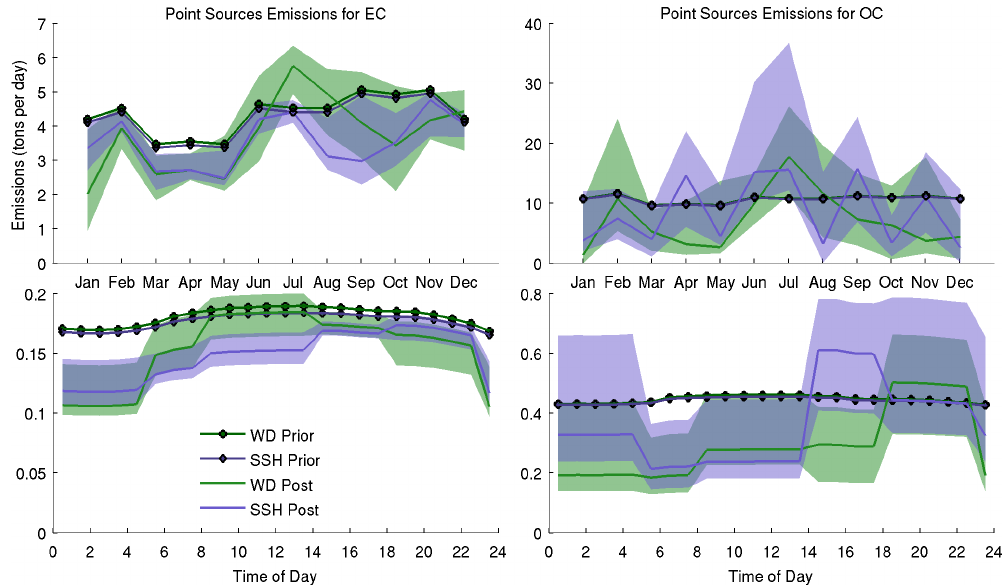
Figure 14. Monthly and diurnal temporal pattern of emissions of EC and OC for point source emissions by weekday and weekend for the St. Louis region, see Fig.